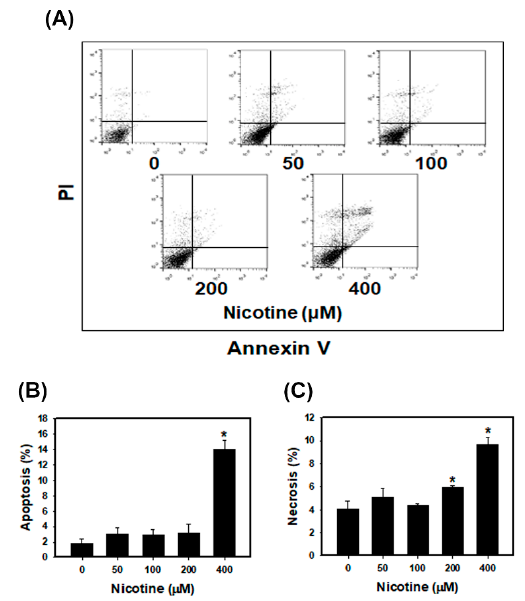
Figure 3. The effects of nicotine on apoptosis and necrosis in HK-2 cells. ( A ) Apoptosis and necrosis were detected using an annexin V/PI staining assay. Quantification of apoptosis ( B ) and necrosis ( C ) in HK-2 cells. The HK-2 cells were treated with various concentrations of nicotine for 24 h. * p < 0.05 compared with the control. Data are presented as the means ± standard deviation of three independent experiments. Statistical significance was estimated with ANOVA by Dunnett’s multiple comparison test.